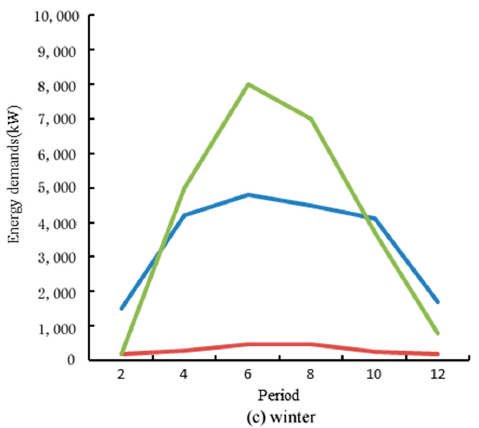
Figure 4. Environmental parameters of energy demand.